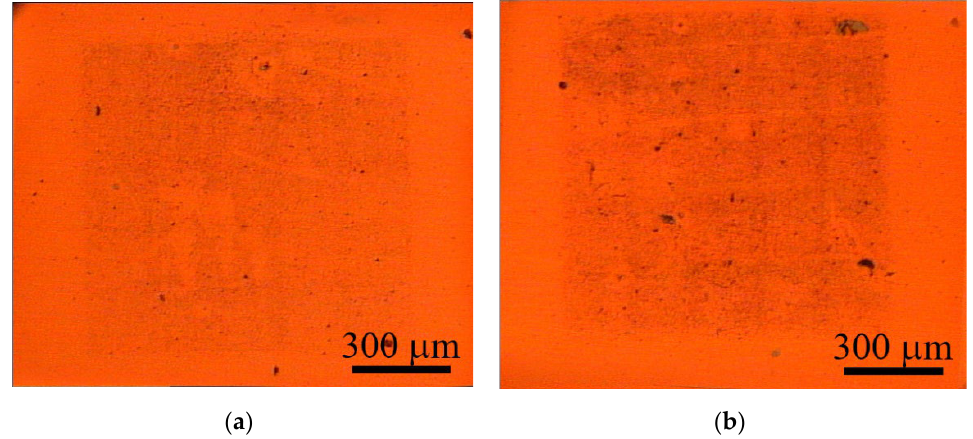
Figure 2. Optical images of complete transferred areas on receiving substrates after single ( a ) and triple ( b ) laser exposure.